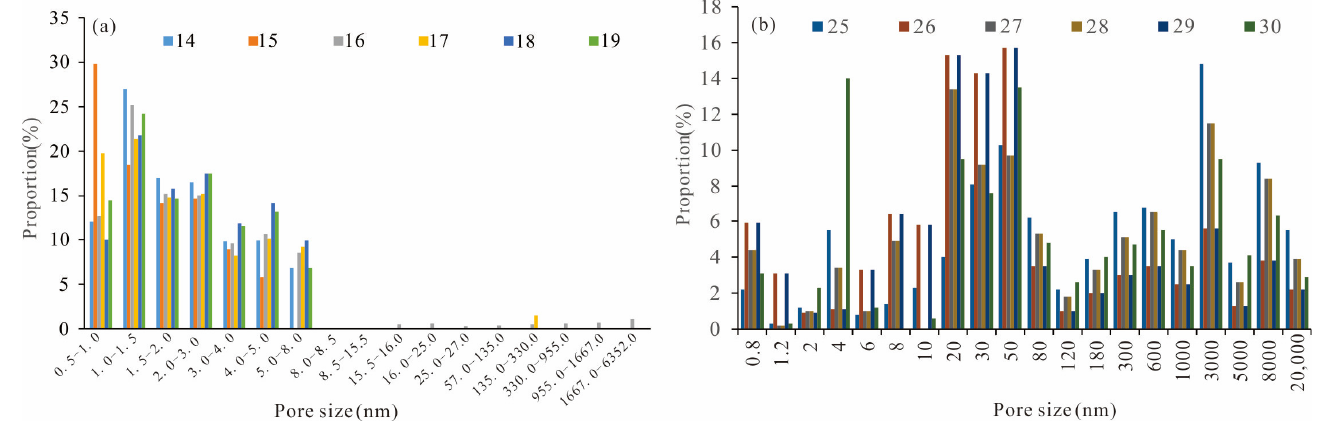
Figure 6. Pore sizes of the Silurian Longmaxi marine-shale samples ( a ) and the Lower Jurassic Dongyuemiao lacustrine-shale samples ( b ).